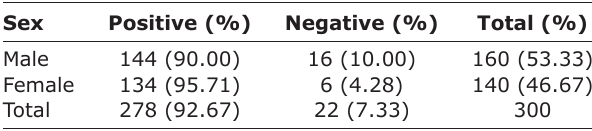
Table-2: Sex distribution of Campylobacter isolates in pigs fecal samples from Zuru Kebbi State.